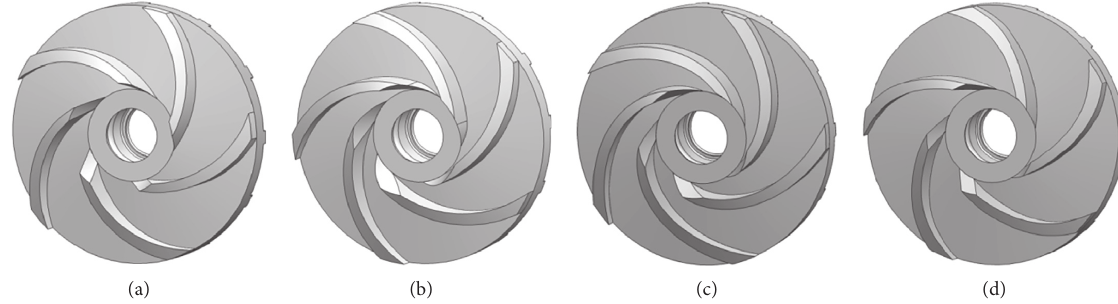
Figure 7: Models of impellers drawn by four profile design methods. (a) Single arc. (b) Double arc. (c) Logarithmic spiral. (d) B-spline curve.